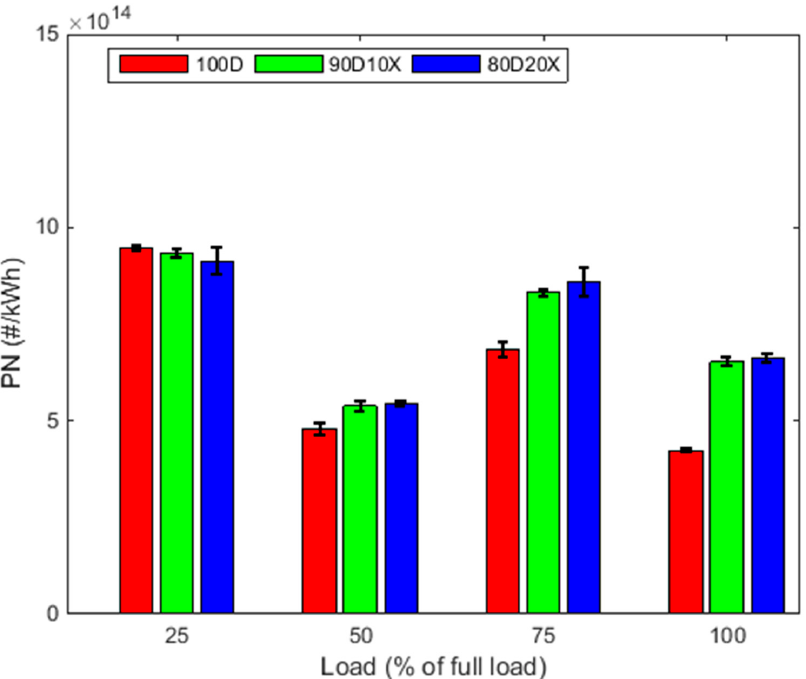
Figure 11. Variation of brake specific particle number (PN) with engine loads for diesel and DOP blends.